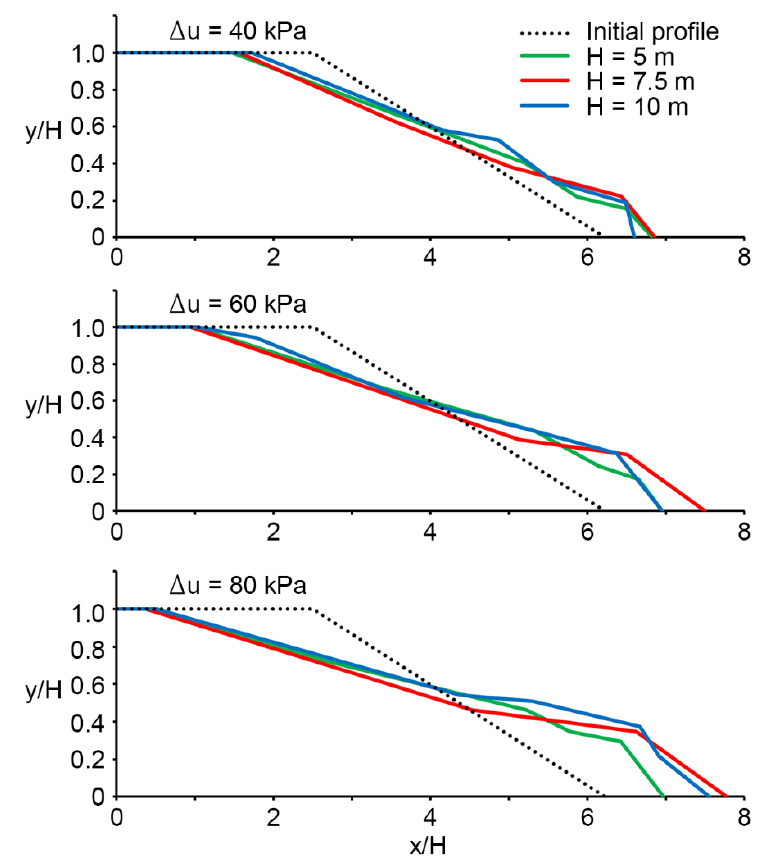
Figure 8. Dimensionless post- failure profiles for the case with α = 15°, φ’ = 35° and different values of Δu and H.